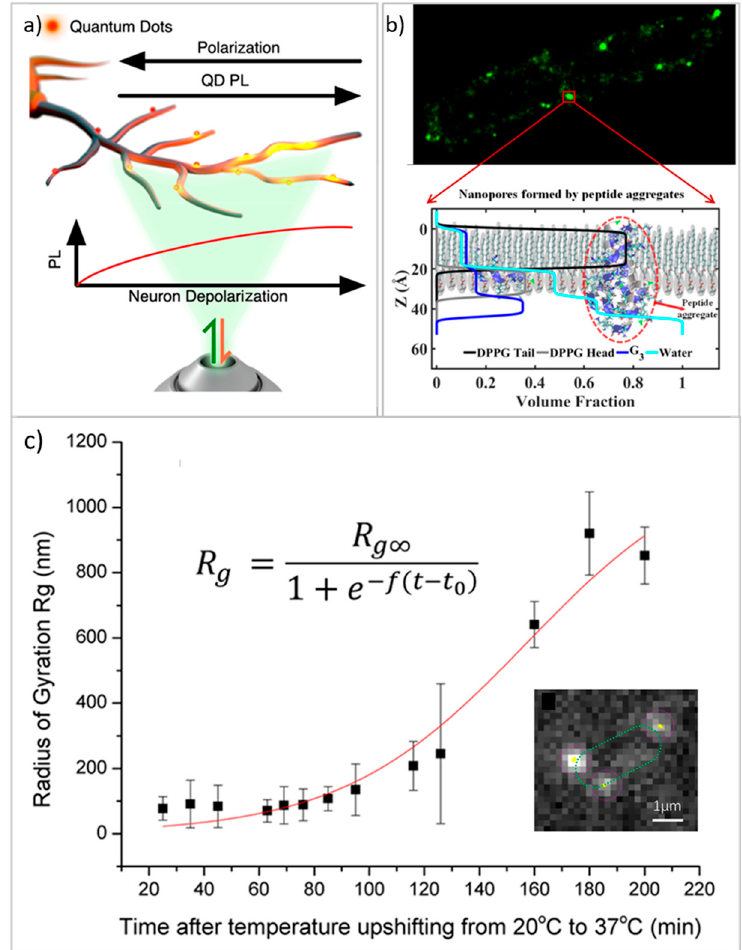
Figure 20. Fluorescent markers indicate ion and molecular transport. ( a ) using QDs to trace ion transport responses on neurons [157]. ( b ) decorated anti-microbial peptides indicate localization on bacterial membrane [158]. ( c ) polyelectrolyte molecules diffused on membrane with a mean square displacement relationship, and transported through bacterial membrane showing the rate of molecular export from inside [156]. Reproduced with permission from ( a ) ref. [157] Copyright (2019), American Chemical Society; ( b ) ref. [158] Copyright (2020), American Chemical Society; ( c ) ref. [156] Copyright (2019), American Chemical